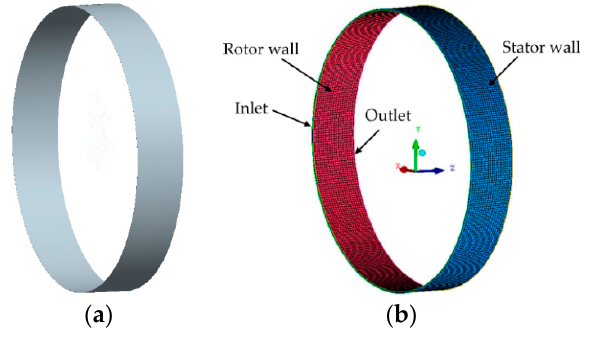
Figure 2. ( a ) Calculation domain and ( b ) grid. Table 1. Geometric parameters and operation conditions.